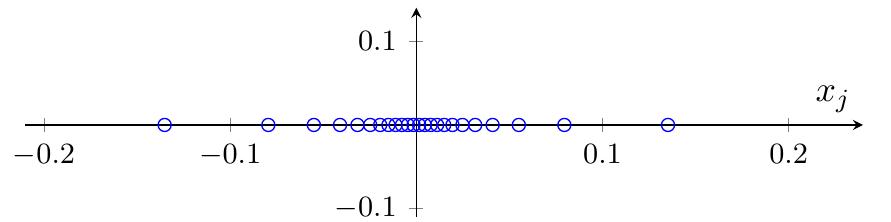
Figure 3: Example for a configuration of the roots x